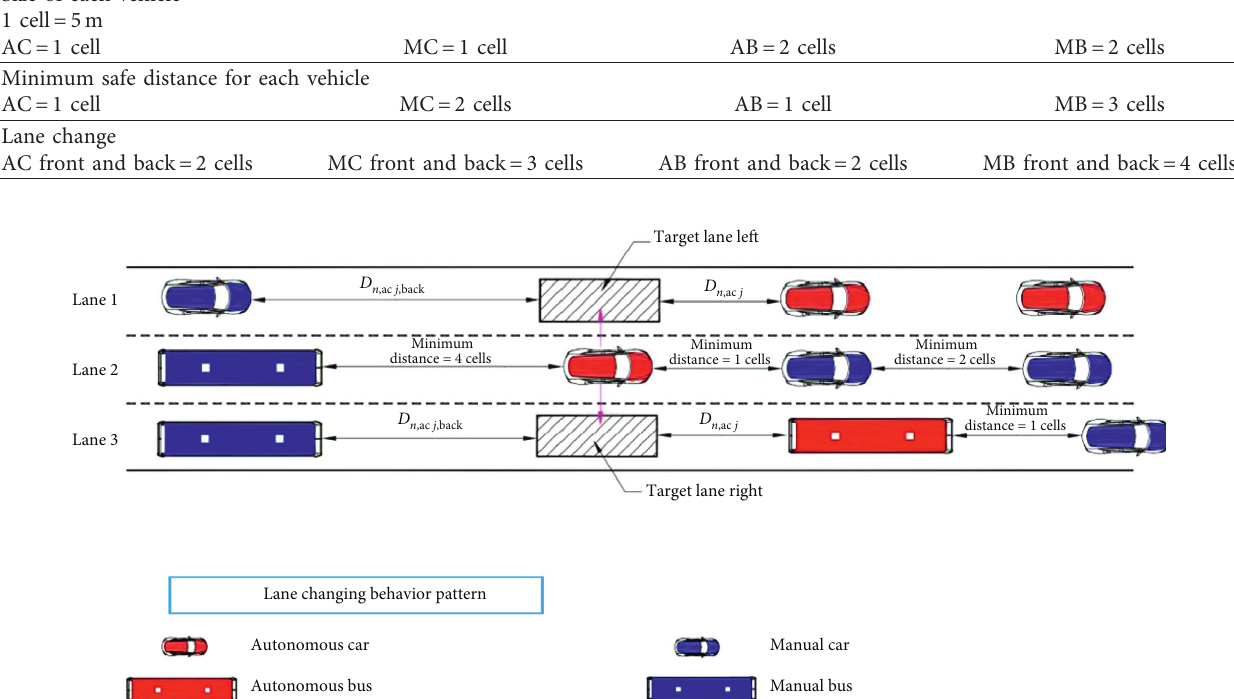
Figure 1: Schematic diagram of model.